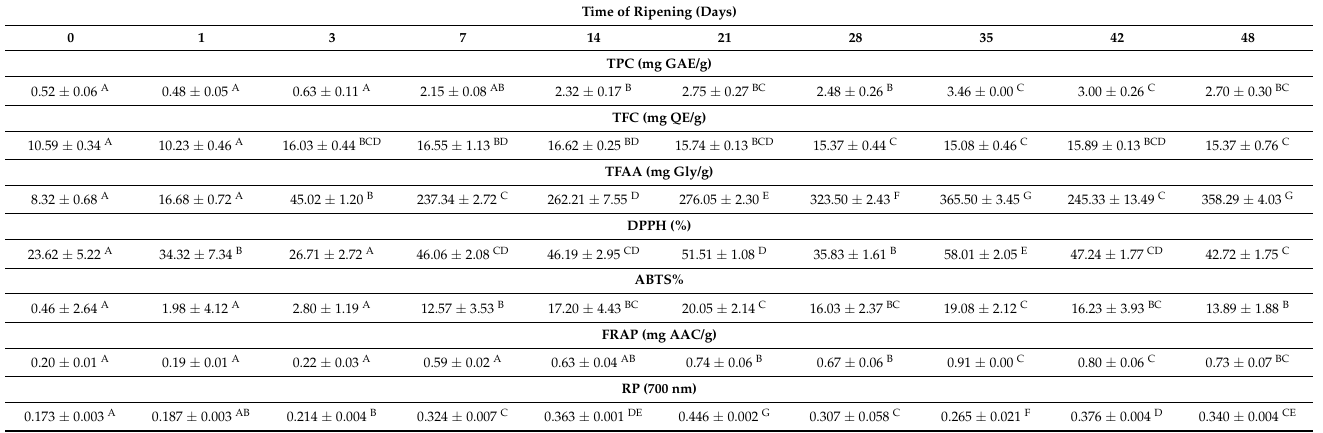
Table 1. The Changes in Total Polyphenolics Content, Total Flavonoids Content, Total Free Amino Acids Level, and Antioxidant